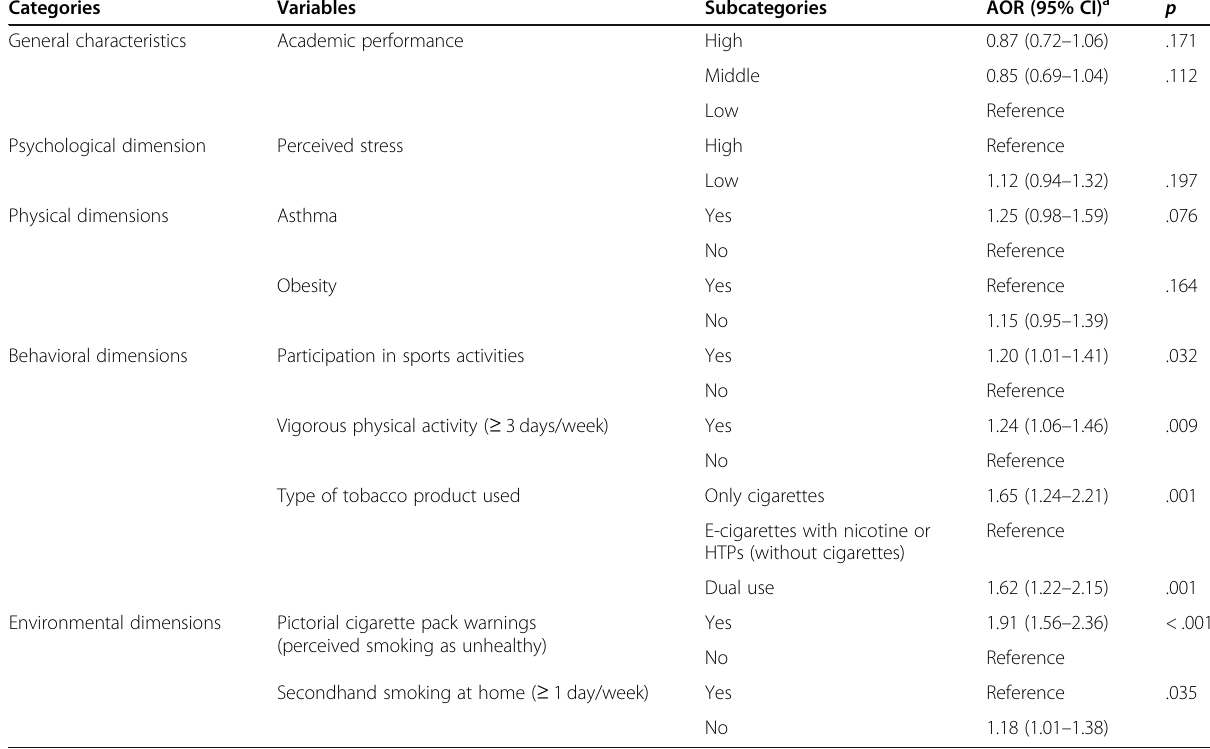
Table 3 Factors influencing attempts to quit using tobacco in adolescent tobacco